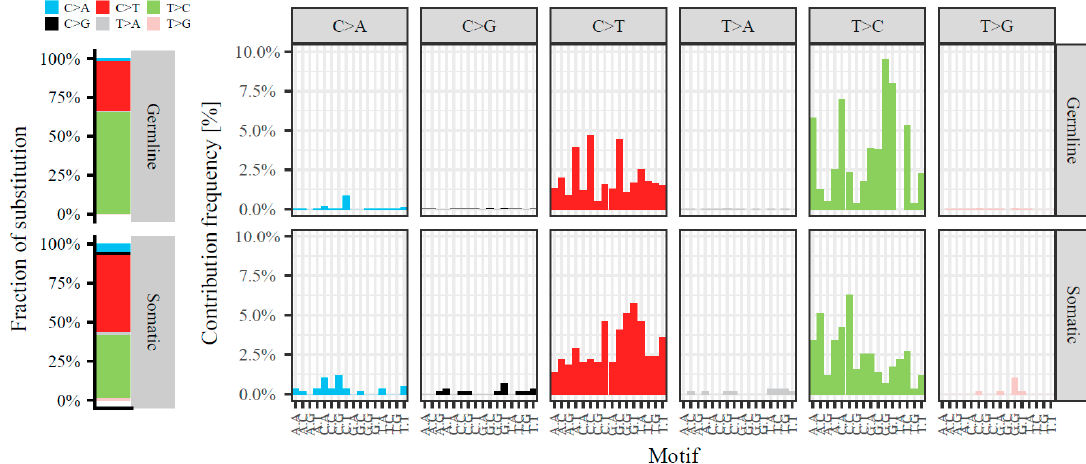
Figure A4. Somatic spectrum of mitochondrial DNA variants of 381 primary breast tumor cases. The contribution of the six possible base substitutions (C > A in blue, C > G in black, C > T in red, T > A in grey, T > C in green and T > G in pink) ( left ) and the context of each substitution (bases immediately 5 ′ and 3 ′ to each variant in the reference genome) ( right ) are depicted for the germline (top) and somatic (bottom) variants.